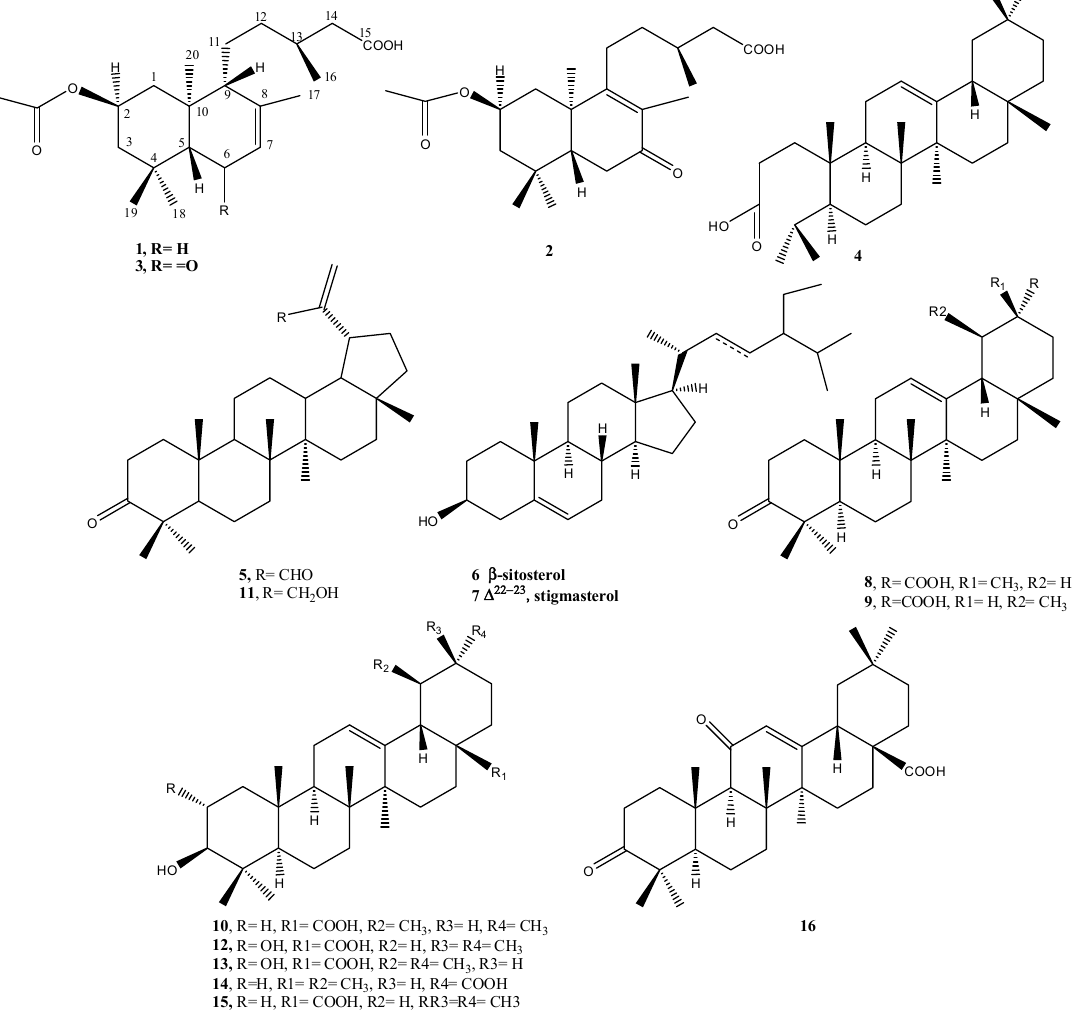
Figure 1. Structures of isolated compounds from aerial parts of N. oppositifolia.